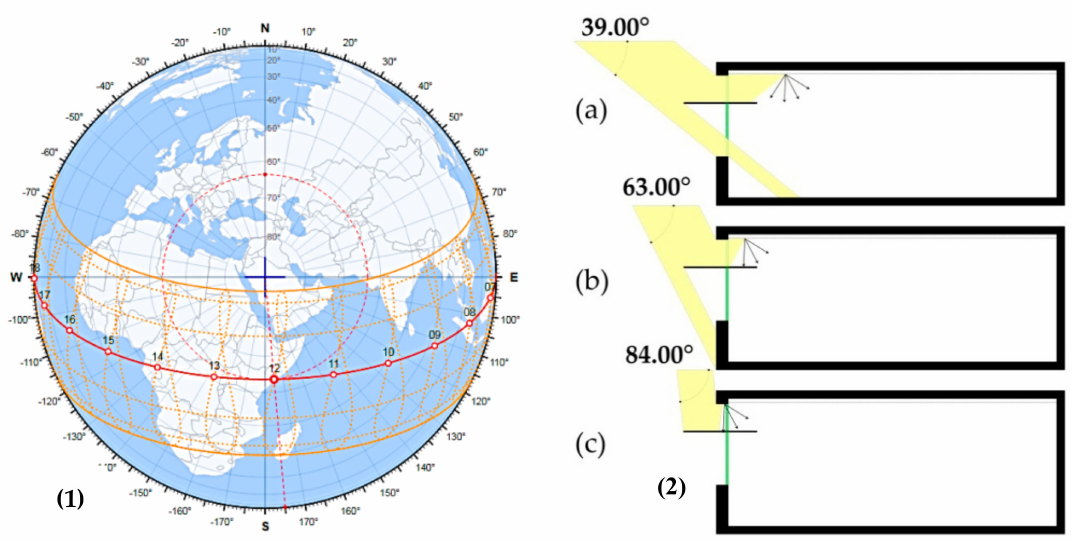
Figure 2. ( 1 ) Sun path at the city of Ha’il using Andrew–Marsh 2D modeling, ( 2 ) the inflow of daylight corresponding to the incident angle of design rays at midday. ( a ) Winter solstice; ( b ) spring / autumn equinox; ( c ) summer